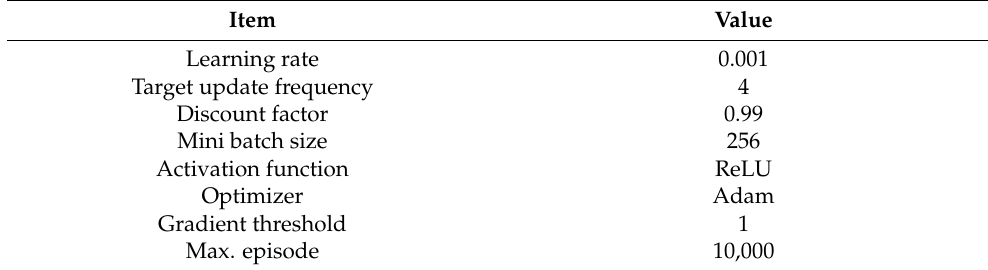
Table 2. Default hyperparameter values and